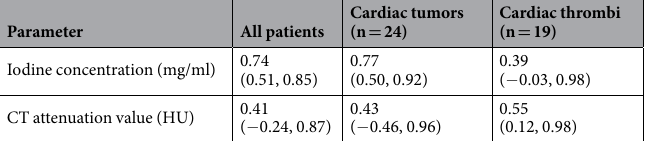
Table 3. Correlation between SI ratio and each variable using replicated measurements (95% CI). SI, signal intensity; CI, confidence interval; HU, Hounsfield units.